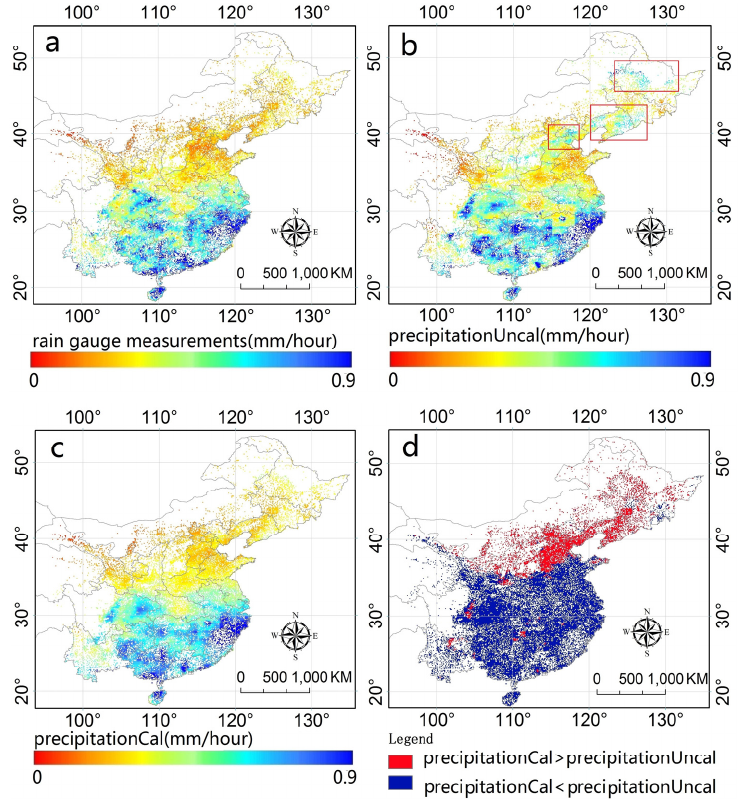
Figure 2. The spatial pattern of the hourly precipitation intensity measured by ( a ) rain gauge measurements; ( b ) un-calibrated Integrated Multi-satellite Retrievals for Global Precipitation Measurement (IMERG) (termed as precipitationUncal); ( c ) calibrated IMERG (termed as precipitationCal); ( d ) the comparison result of precipitationUncal and precipitationCal for each grid during April~October in 2014.